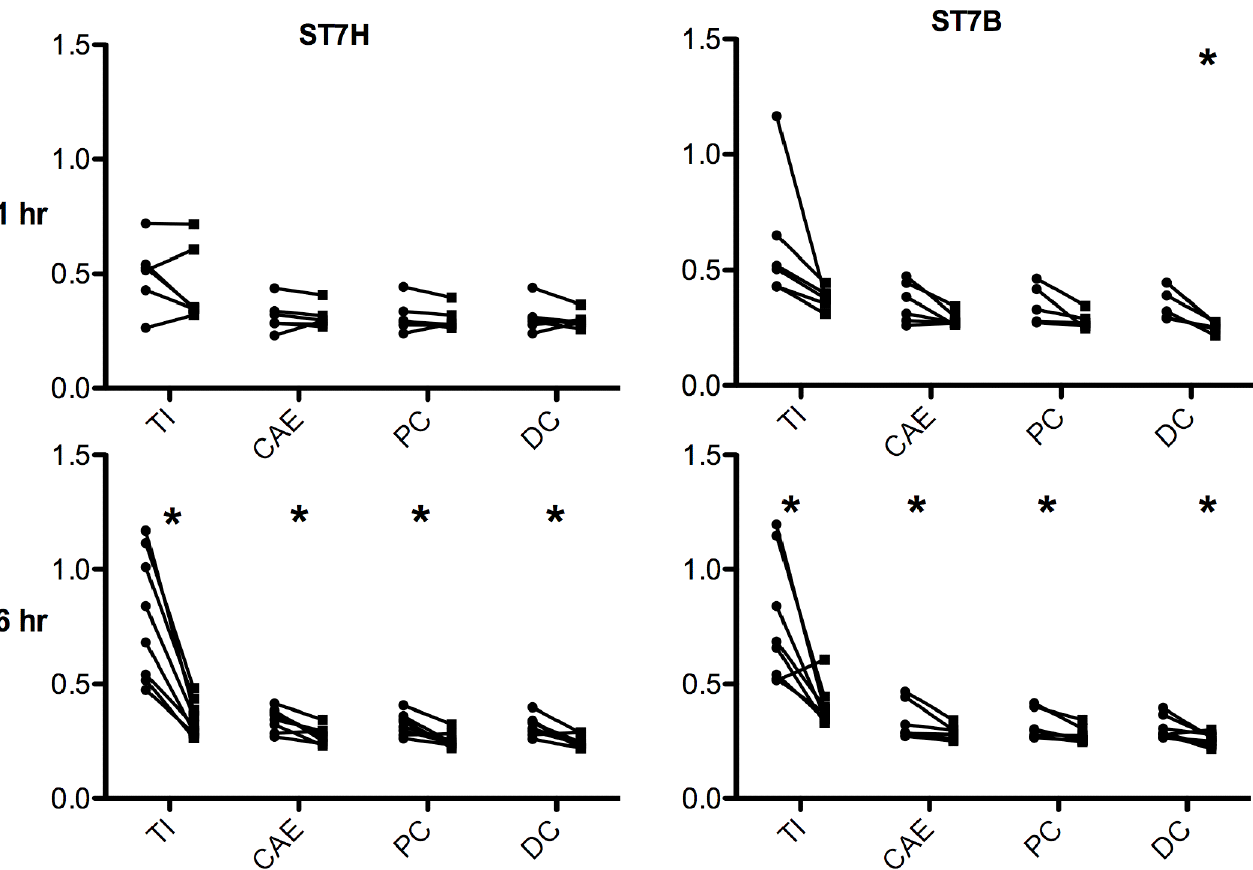
Fig 2. Mucinolytic effects of Blastocystis spp. Levels of mucin in the supernatants of paired infected and uninfected explant tissue. Significant mucin degradation in the infected explants at 6 hours was seen for both isolates but only ST7-B showed degradation of colonic mucin at 1 hour. Mucin levels were estimated by ELLA and the data is representative of explants from at least 5 mice each. * p < 0.05.